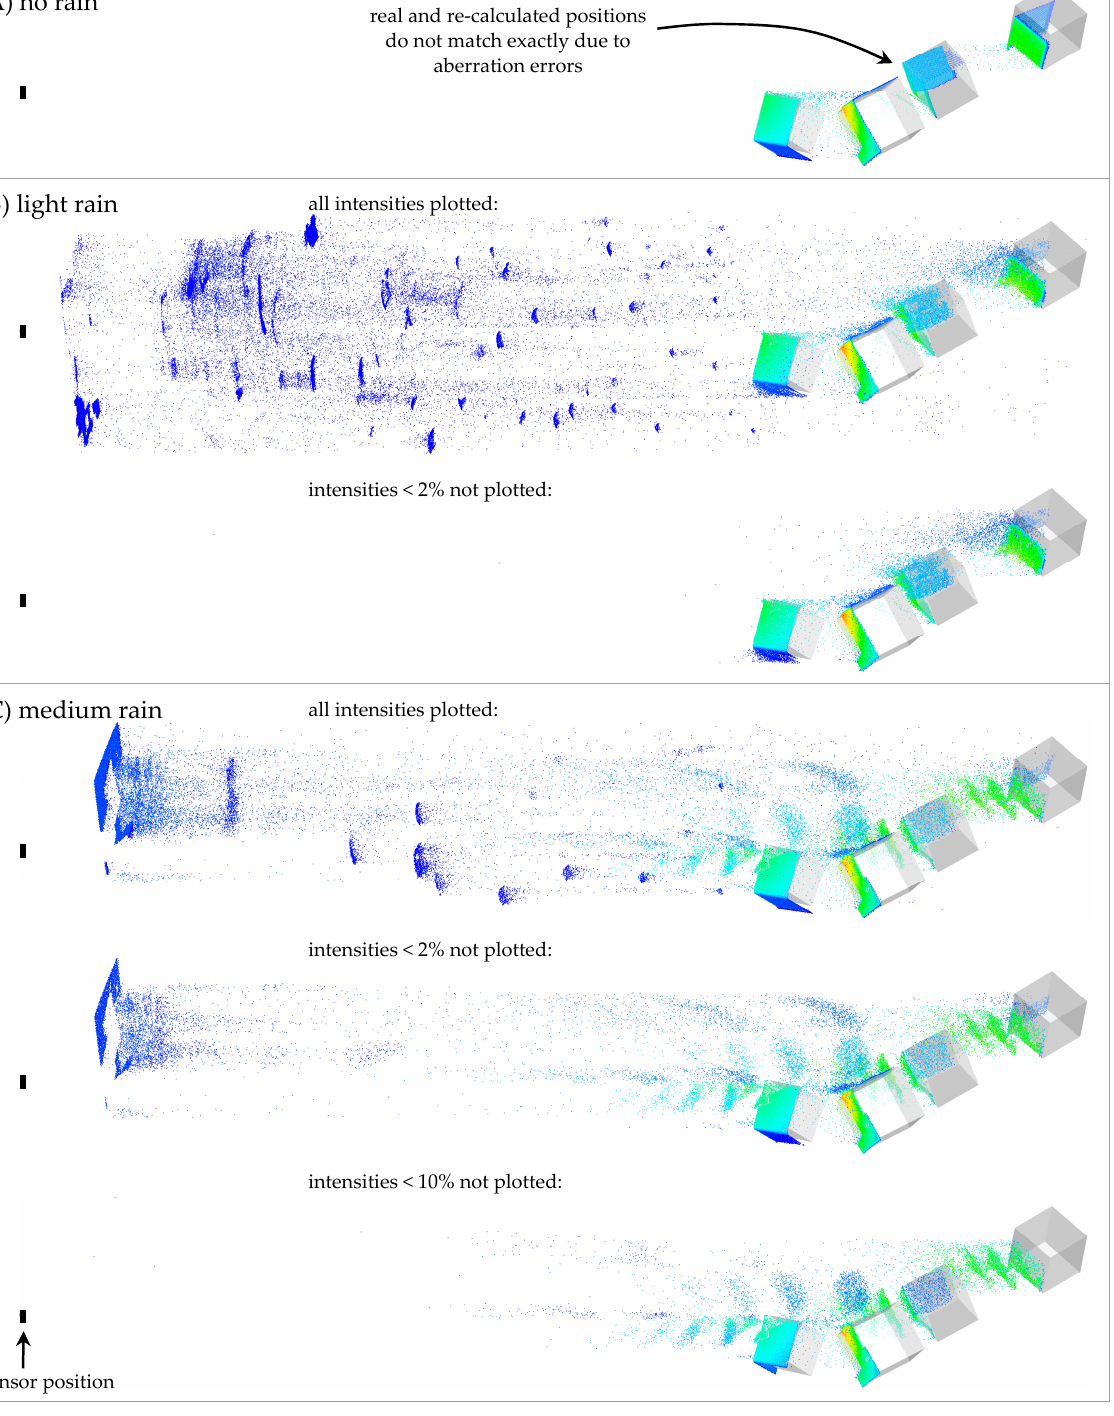
F igure 3. 3D intensity and depth plots comparing different relative minimum intensities for ( A ) no rain; ( B ) light rain; and ( C ) medium